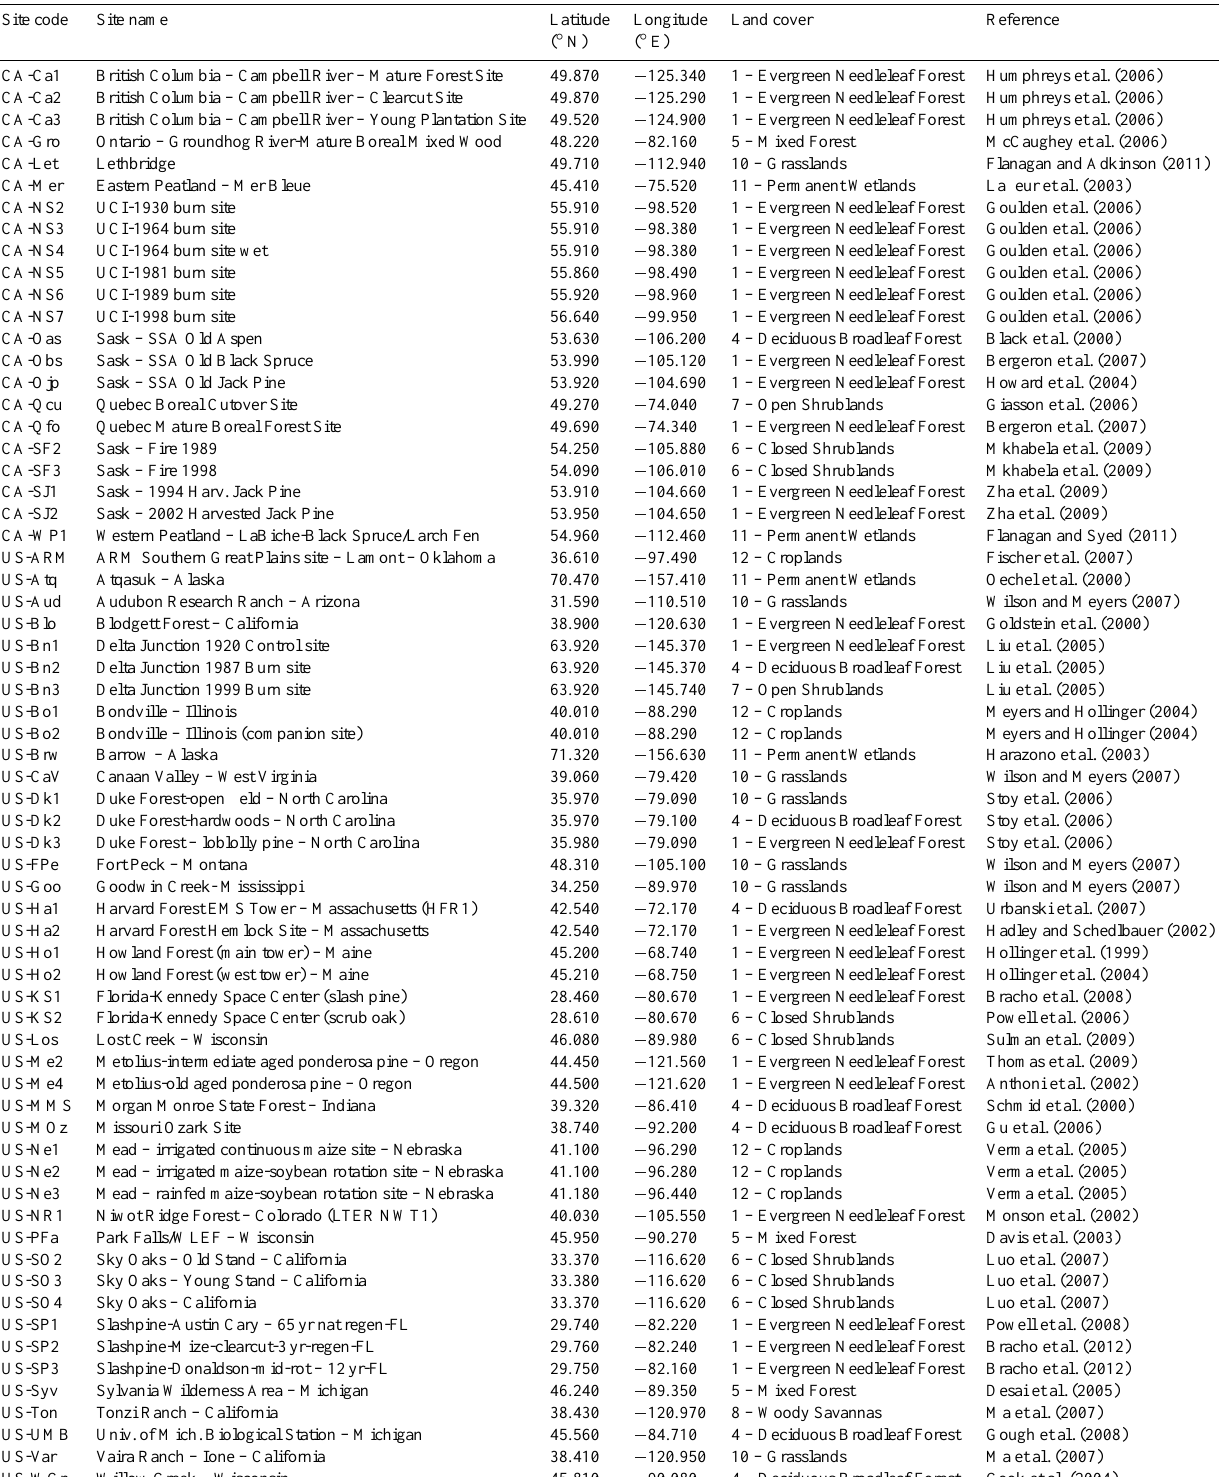
Table 1. 65 North American eddy covariance sites used to parameterize VPRM and calculate VPRM flux errors. PFTs are taken from the International Geosphere-Biosphere Programme (IGBP) land cover classification scheme (Loveland and Belward, 1997). The PFT classifica- tions are taken from literature citations or investigator descriptions where available, and otherwise derived from MODIS 1km land surface classifications. Data are from the 2007 FluxNet synthesis